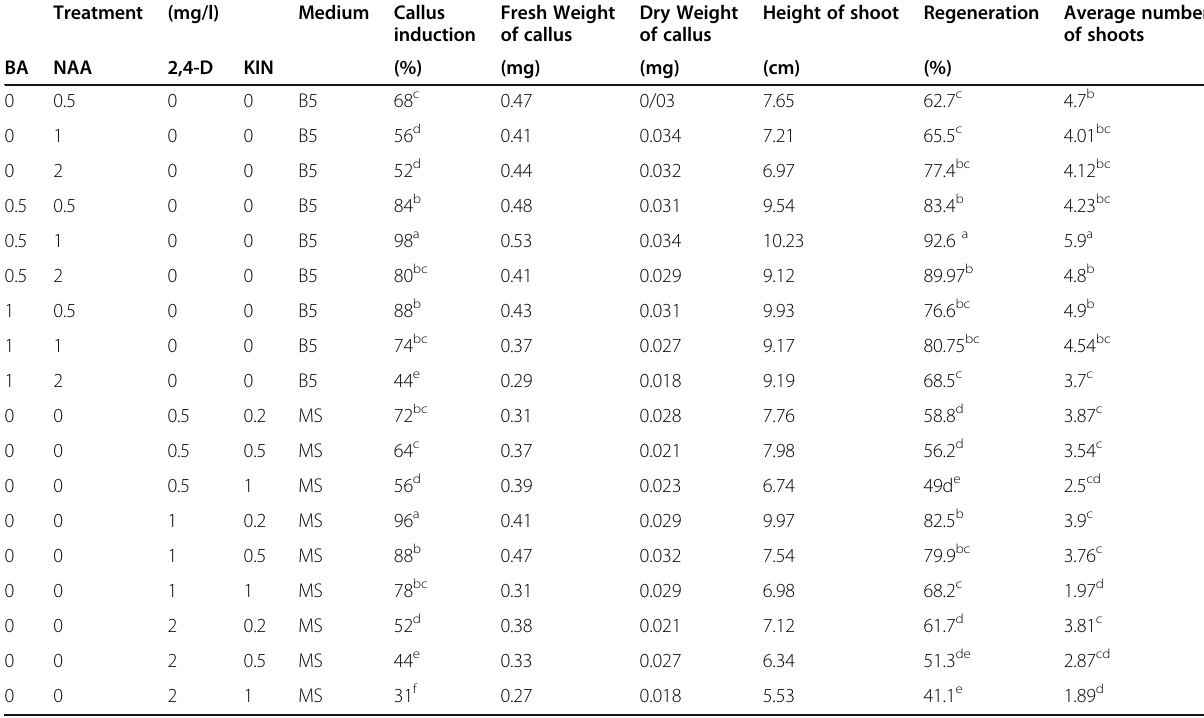
Table 1 Effect of Murashige and Skoog (MS) and Gamborg ’ s B5 (B5) media with diverse concentrations of plant growth regulators, 6-benzyladenine (BA), 1-naphthaleneacetic acid (NAA), 2,4-dichlorophenoxyacetic acid (2,4-D), and kinetin (KIN) to regenerate Trachyspermum ammi by zygotic embryos Treatment